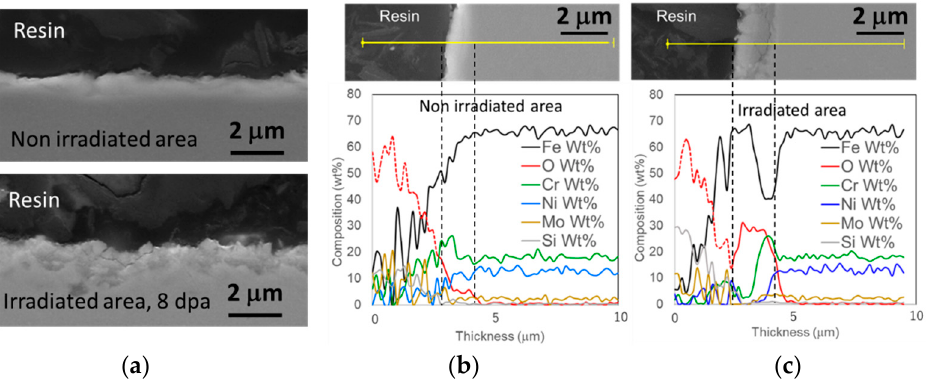
Figure 5. Cross-sectional SEM images and EDS line spectra after conducting corrosion tests for the specimen irradiated up to 8 dpa. Upper and lower images of ( a ) correspond to that of nonirradiated and irradiated areas, respectively. Figures ( b , c ) denote the compositions of nonirradiated and irradiated areas respectively, measured by an EDS line analysis, which was shown in the upper image. The oxygen concentration was 2.4 × 10 − 4 wt.% in LBE at 450 °C. The red dotted and gray lines are signals come from the compositions of silicone oil.